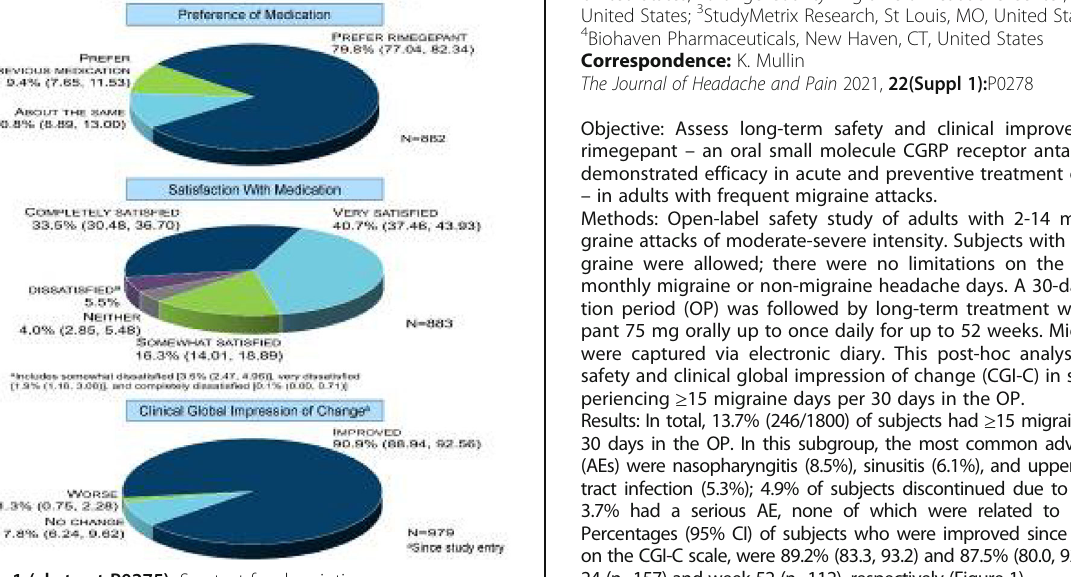
Fig. 1 (abstract P0275). See text for